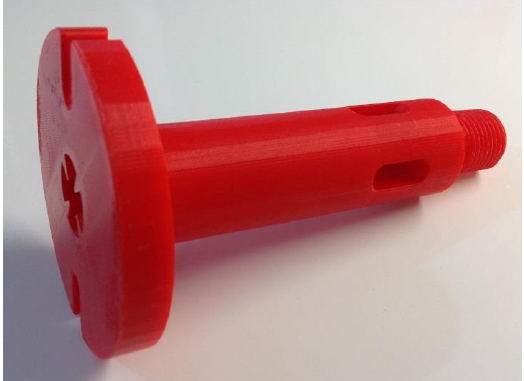
Figure 12. Experimental ejector. Source: authors’ development.